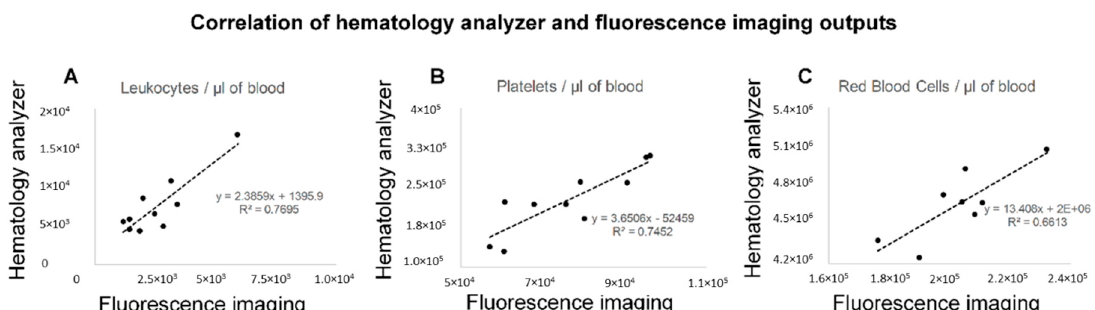
Figure 5. Scatter plots of leukocyte (Panel A ), platelet (Panel B ), and red blood cell frequencies (Panel C ) in 1 µ L of whole blood of 10 healthy individuals as estimated by fluorescence imaging and ACCEPT enumeration ( x -axis) and by the hematology analyzer ( y -axis). Correlation between the measurements of the two techniques was found as indicated by the R 2 . The mean counts of each population of 4–6 technical replicates were used in the case of the fluorescence imaging approach.